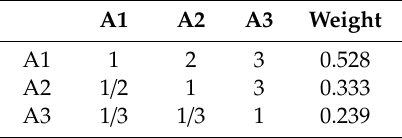
Table A9. Pairwise comparison matrix of rural access indicators.